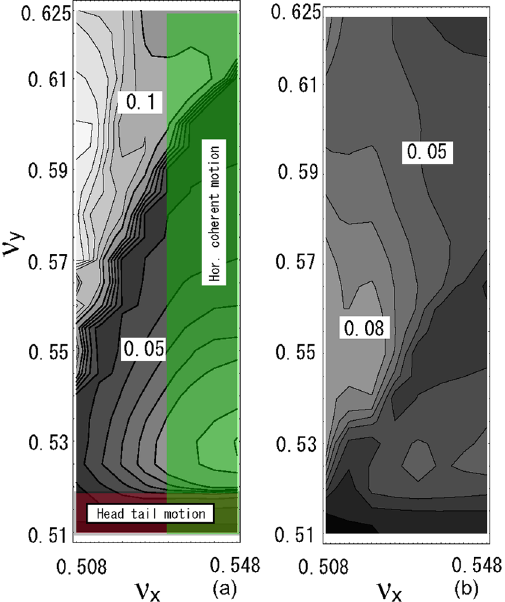
FIG. 6. (Color) Beam-beam parameter ( The beam-beam parameter for the crossing angles of 0 and 11 mrad are depicted in (a) and (b), respectively. The contour lines are drawn every 0.01, and lighter gray corresponds to higher beam-beam